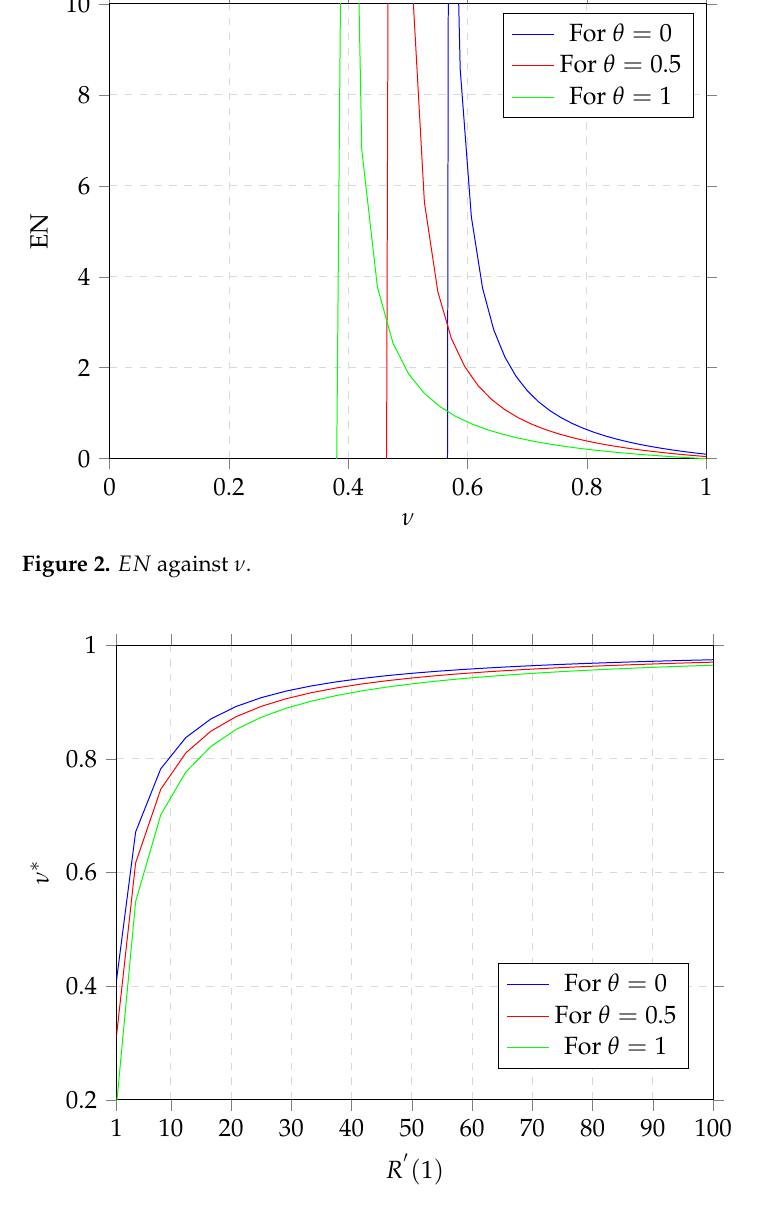
Figure 3. The stability abscissa against the mean repair